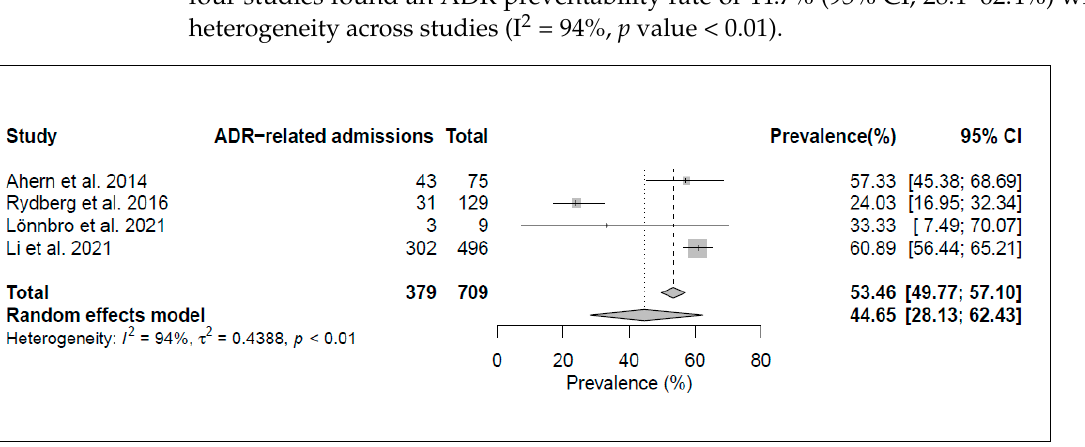
Figure 5. Forest plot of the pooled preventability rates of ADE-related ED visits/hospital admis- sions [39,40] . 3.7. Implicated ADRs For the analysis of implicated adverse events and drugs, we exclusively considered studies which reported on ADRs. Of 14 studies, 9 (64.3%) were included in the analyses, with the other 5 studies either providing no [37,40] or no exact [5] numbers on ADR/drug frequencies, or reporting proportions with denominators that were incompatible with our analyses [29,31]. Of the seven studies that provided the numbers of implicated ADRs, four reported prevalence rates of implicated ADRs as proportions of patient cases with ADR-related admissions ( type A prevalence rates) [28,32,33,43], and five studies reported them as pro- portions of all ADRs ( type B prevalence rates) [28,30,38,41,43], i.e., from two studies both prevalence types could be extracted [28,43]. The list containing all ADR frequencies is pro- vided in File S5. Our iteratively developed ADR coding frame distinguishes 19 ADR categories and 56 individual ADRs. Table 2 ranks type A prevalence rates of ADR categories at the high- est level in descending order of estimated point prevalence rates. Full details of lower hierarchical levels and type B prevalence rates are provided in File S8. Four ADR categories had type A prevalence rates of ≥ 10.0% in meta-analysis, where gastrointestinal disorders were the most common (28.5 [95% CI: 21.6; 36.6]%), followed by electrolyte disturbances (16.5 [9.5; 25.7]%), bleeding events (13.5 [9.5; 18.8]%), and renal and urinary disorders (11.8 [5.4; 24.1]%). All of these also accounted for ≥ 10.0% of all ADRs in studies reporting type B prevalence rates and no further ADR was found to have a type B prevalence rate of ≥ 10.0%.